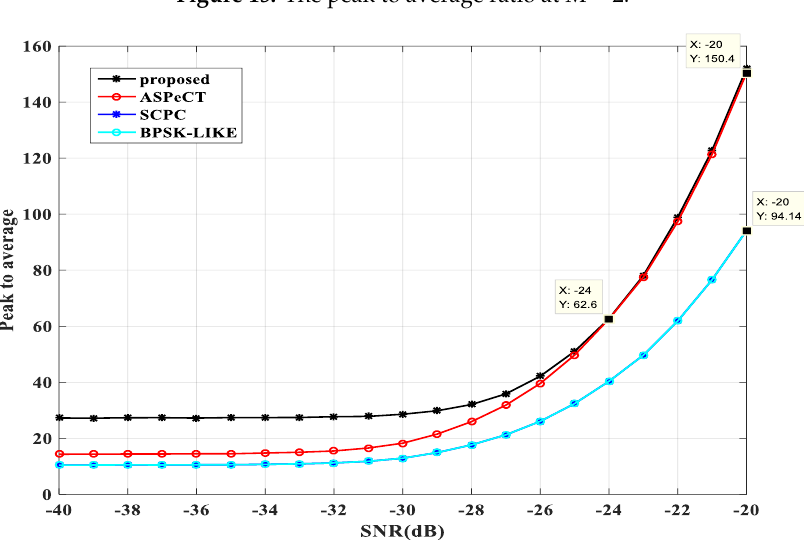
Figure 16. The peak to average ratio at M = 4.